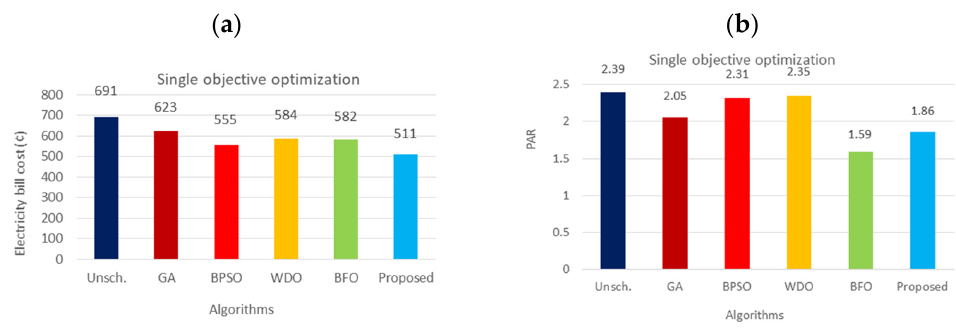
Figure 5. Comparison of the results with previous ones [17]: ( a ) daily total cost, and ( b ) PAR.